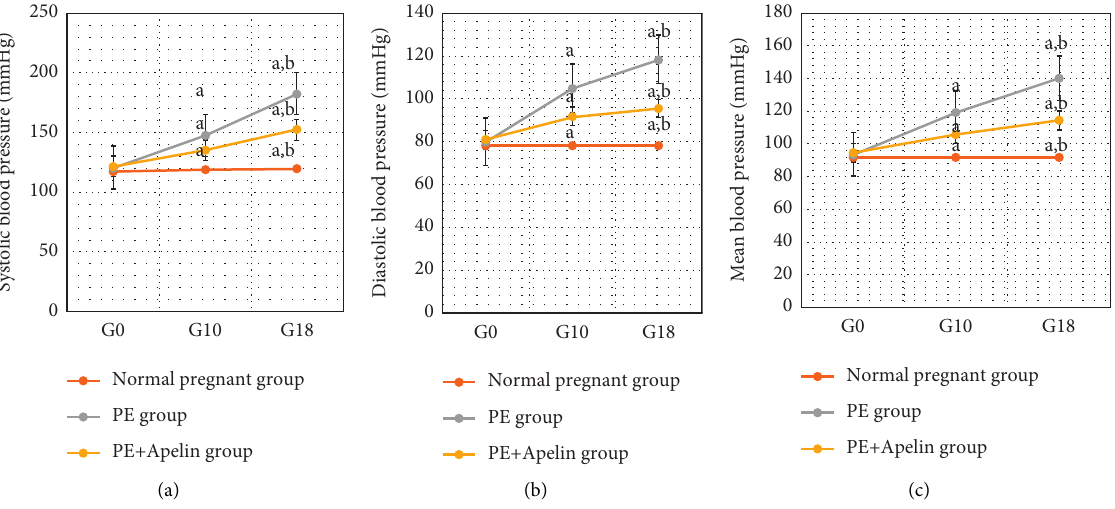
Figure 3: (a)–(c) Systolic, diastolic, and mean arterial blood pressures in all studied